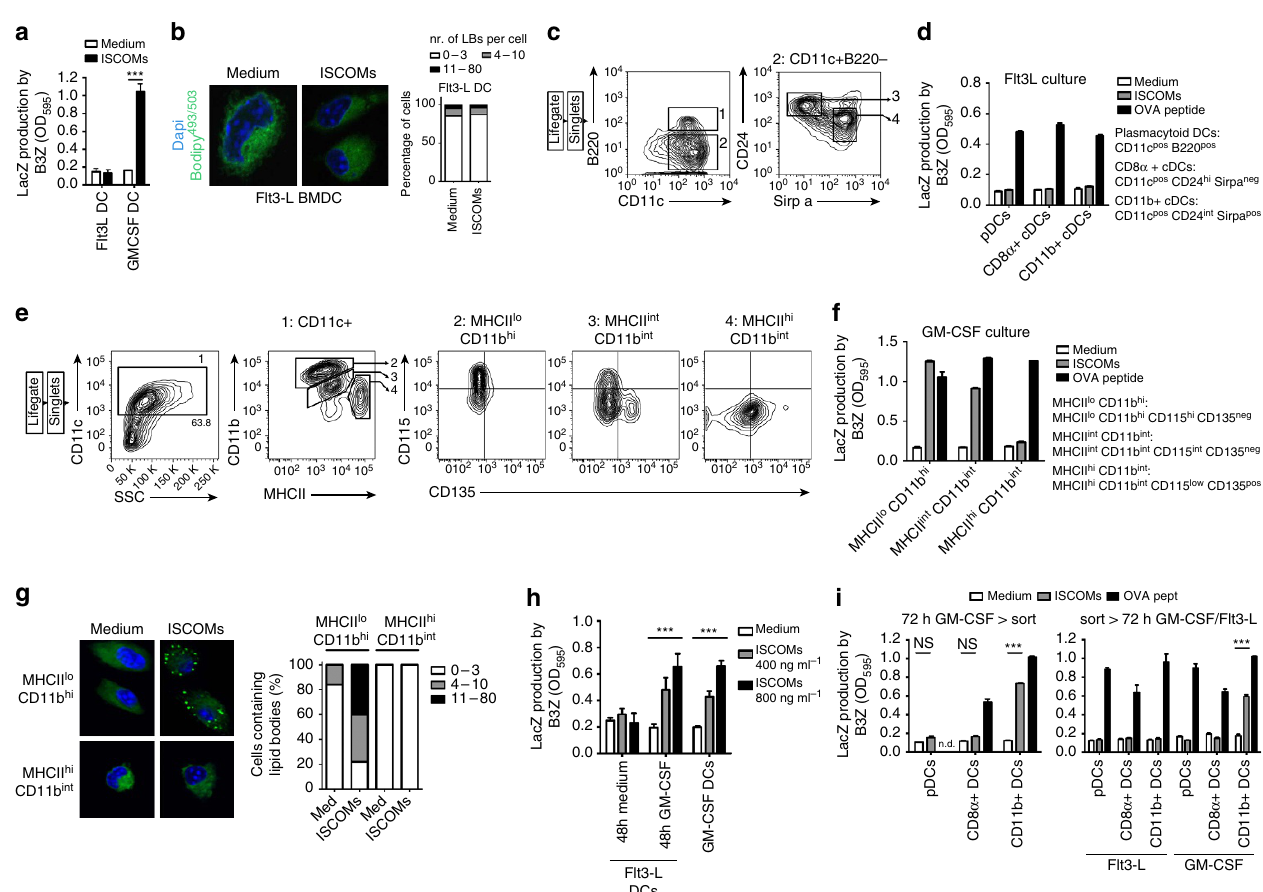
Figure 4 | Responsiveness to SBAs in vitro is unique to CD11b þ DCs with monocytic origin. ( a ) In vitro cross-presentation assay using GM-CSF- or Flt3-L-propagated DCs. ( b ) Confocal images with LB quantifications from Flt3-L-generated BMDCs exposed for 5h to medium or ISCOMs. ( c ) Gating strategy of Flt3-L DCs. Sorted populations are gate 1 (pDCs), gate 3 (CD8 a þ DCs) and gate 4 (CD11b þ DCs). ( d ) In vitro cross-presentation assay using the populations as sorted under c . ( e ) Gating strategy of GM-CSF DCs. Sorted populations are gate 2 (MHCII lo CD11b hi ), gate 3 (MHCII int CD11b int ) and gate 4 (MHCII hi CD11b int ). ( f ) In vitro cross-presentation assay using the populations as sorted under e . ( g ) CLSM image and LB quantification of populations as sorted under e , after 5h exposure to ISCOMs or medium. ( h ) In vitro cross-presentation assay on Flt3-L- or GM-CSF-cultured bonemarrow DCs. In the 10 day Flt3-L cultures, medium was supplemented for the last 48h with 20ngml (cid:2) 1 GM-CSF or medium. ( i ) In vitro cross-presentation assays on Flt3-L-cultured DCs, receiving GM-CSF for 72h after the end of culture. In the left panel the entire day 10 cultures were supplemented with GM-CSF for another 72h, after which the resulting populations were sorted (Supplementary Fig. 8). In the right panel the day 10 cultures were sorted, after which the individual populations were treated with fresh Flt3-L or GM-CSF. All data were reproduced in two to three independent experiments. Statistical analyses were performed using two-way ANOVA with post hoc Bonferroni